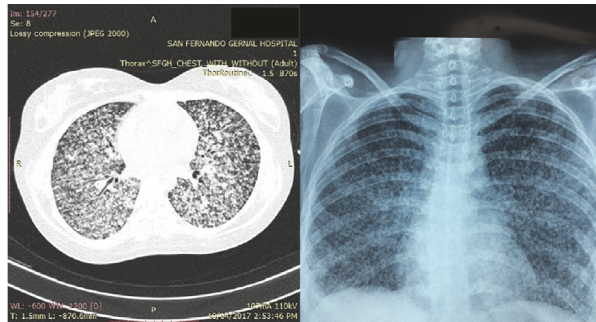
Figure 1: CT scan and CXR of patient showing bilateral miliary